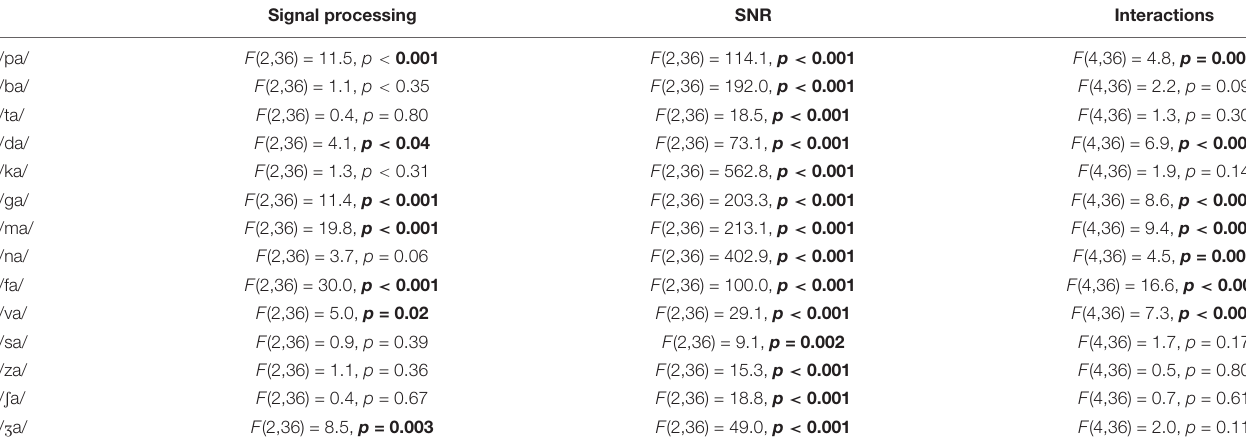
TABLE 2 | Results of two-way ANOVA for each consonant with two factors: signal processing and signal-to-noise ratio (SNR). Signal processing SNR